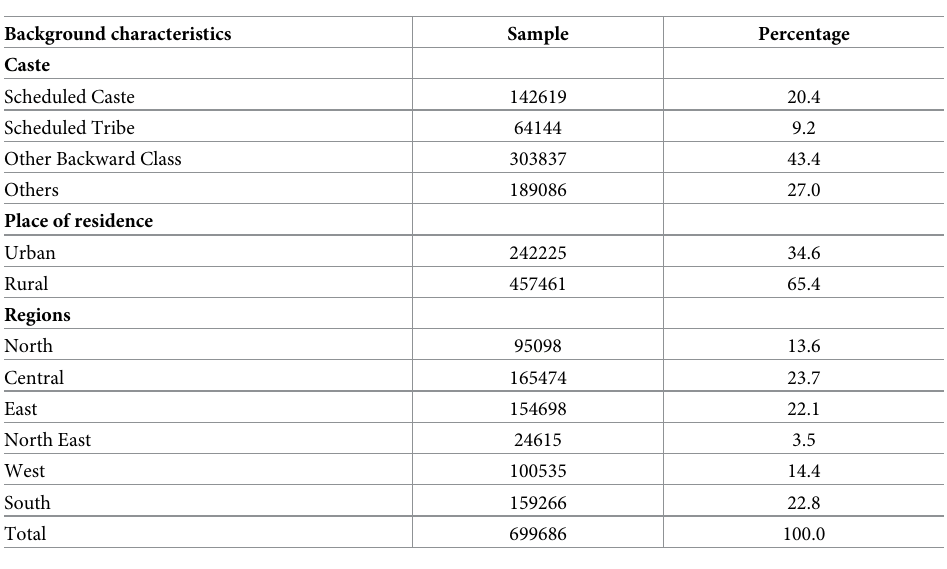
Table 3 represents logistic regression estimates for multimorbidity among women aged 15–49 years in India. Women from age group 35+ years were 6.37 times significantly more likely to suffer from multi-morbidity than women from age group 15–24 years. Women who were pri- mary educated were 10% significantly more likely to suffer from multi-morbidity than women